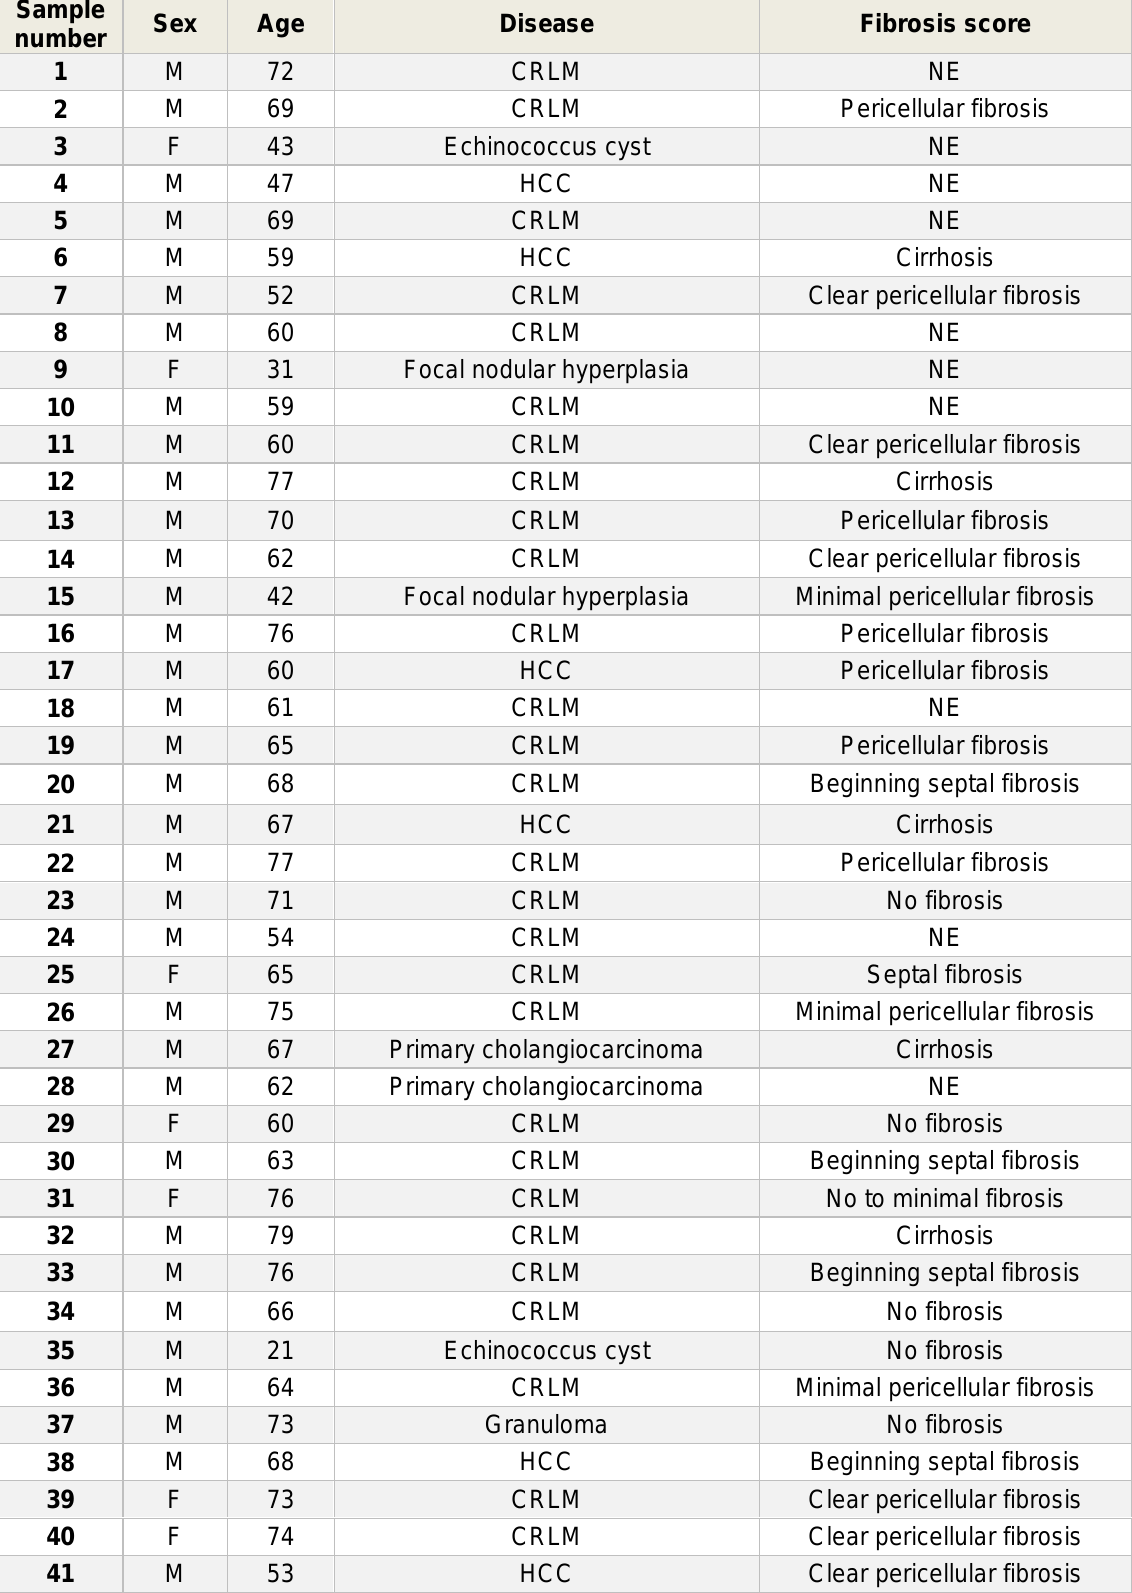
Table 1: Overview of the human liver samples analyzed in this study. An overview of the sex, age, disease and fibrosis score of the donors is provided (M, male; F, female; CRLM, colorectal metastasis; HCC, hepatocellular carcinoma; NE, not